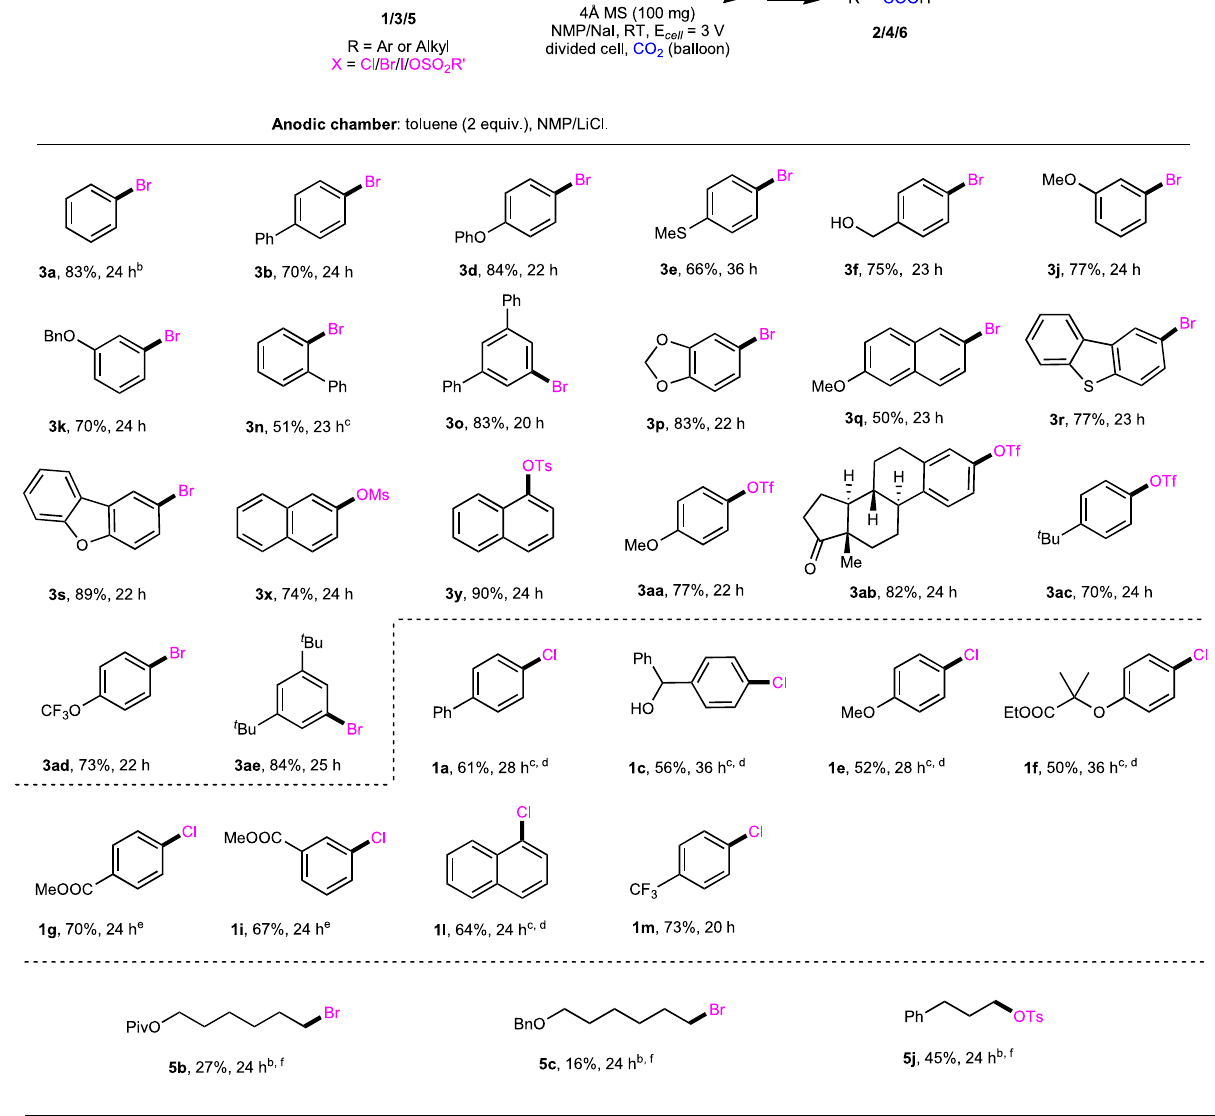
Fig. 4 Scope of organo(pseudo) halides in non-sacri fi cial electrode manner. a Reaction conditions, see more details in Table S2 in “